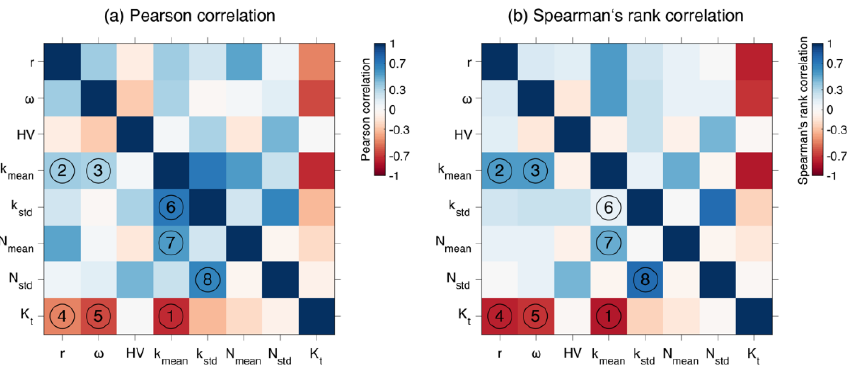
Figure 15. Correlation between maximum likelihood parameters and influencing factors based on ( a ) Pearson (linear) and ( b ) Spearman’s (non-linear) rank correlation coefficient.